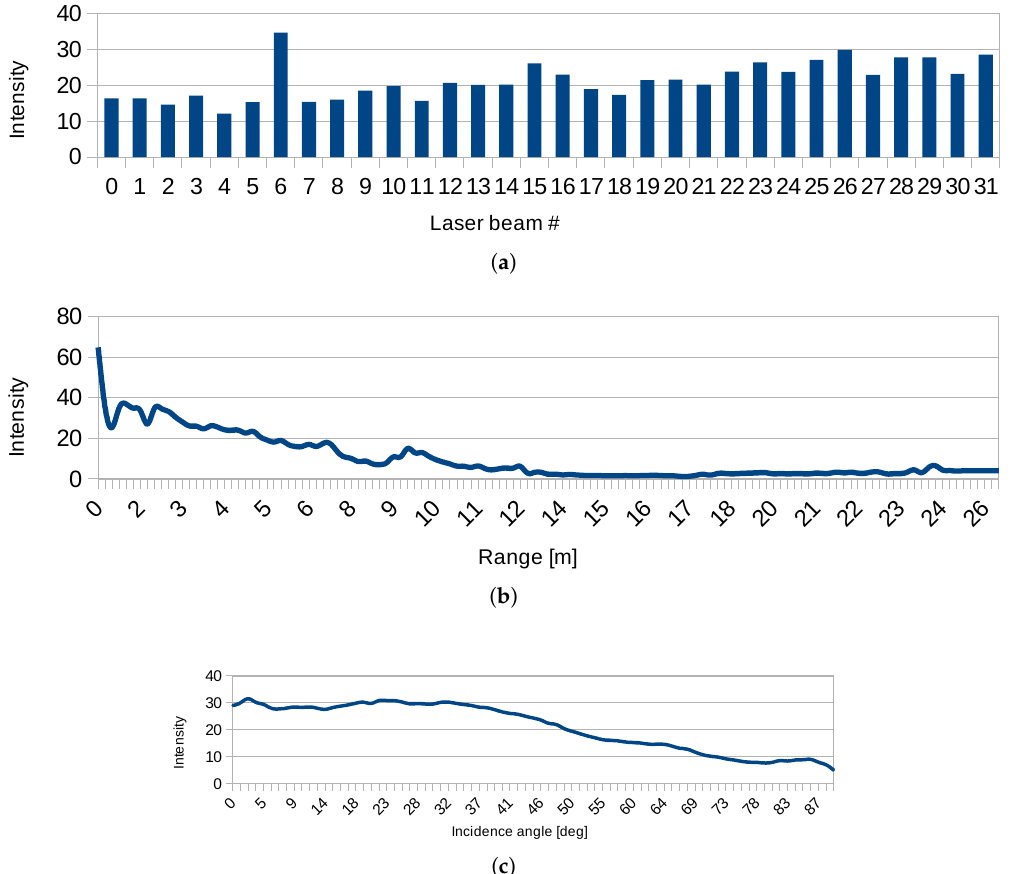
Figure 18. The dependency of laser return intensity on: the source beam ( a ); range of the measurement ( b ); and the angle of incidence ( c ). We are using 2 LiDAR scanners with 16 laser beams per each scanner, 32 beams in